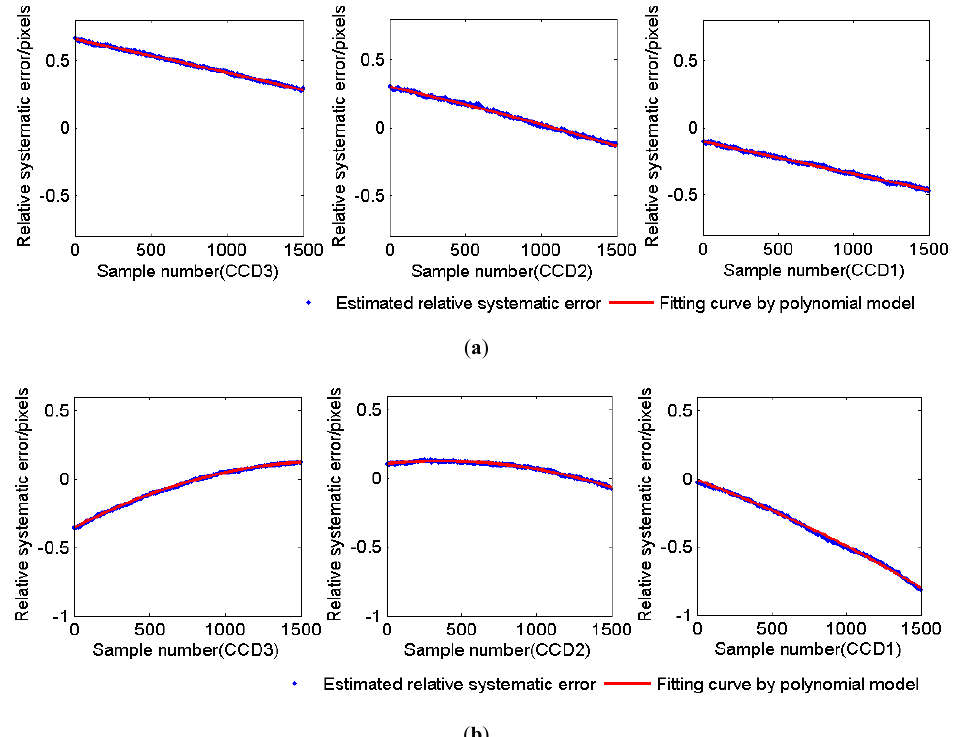
Figure 7. Relative systematic error between B1 and B2 in Scene B. ( a ) Across the track and ( b ) along the track.